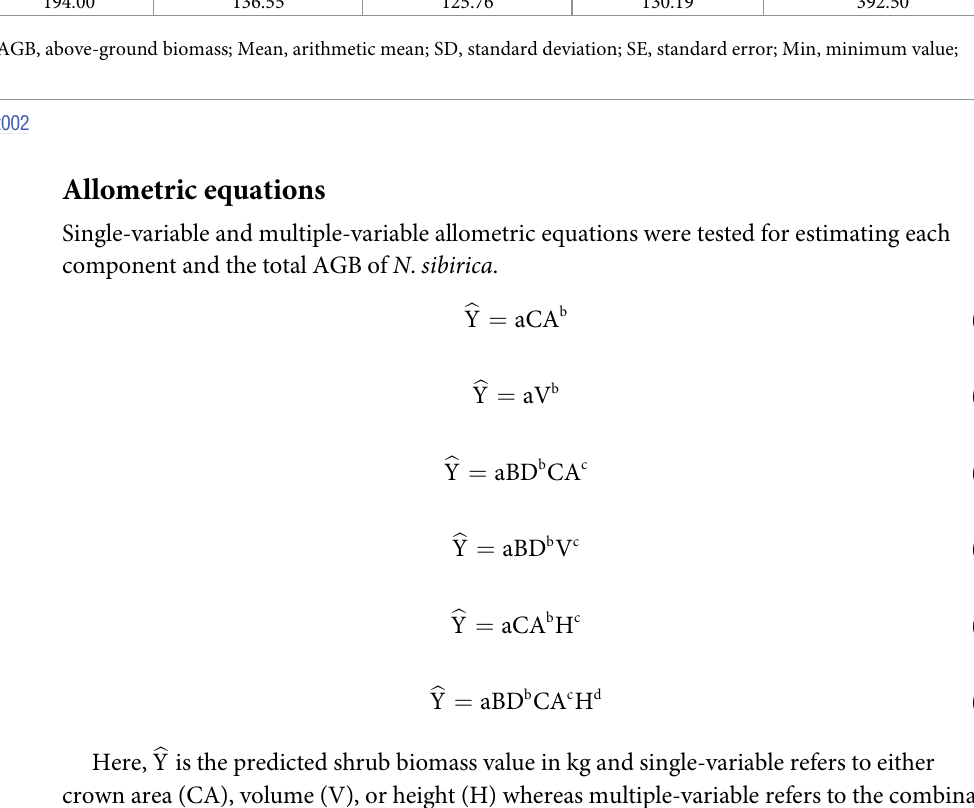
Note: BD, basal diameter; H, shrub height, AGB, above-ground biomass; Mean, arithmetic mean; SD, standard deviation; SE, standard error; Min, minimum value; Max, maximum